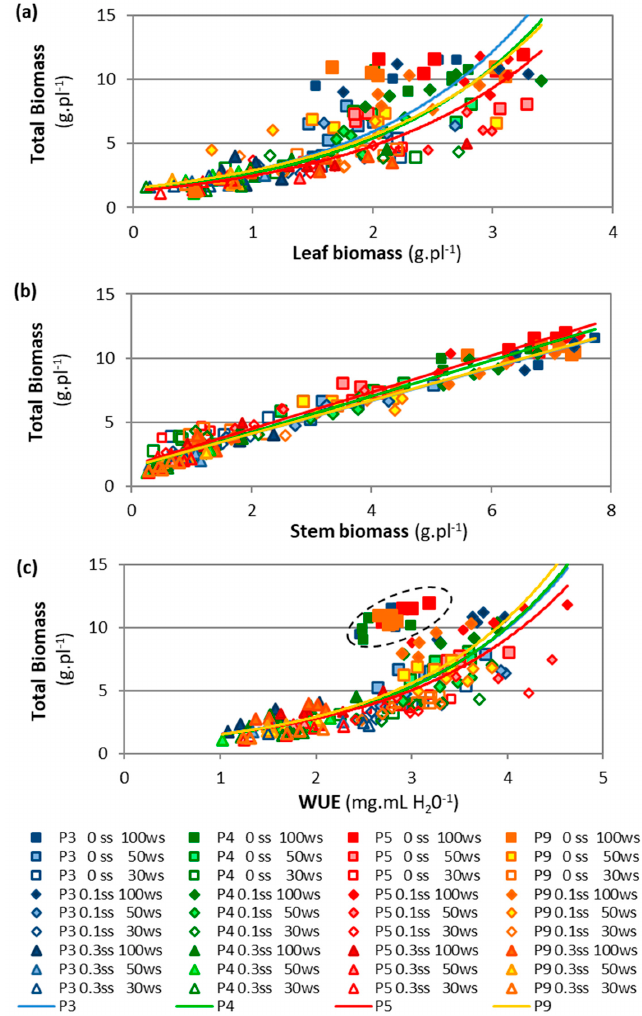
Figure 4. Relationship between total biomass and leaf biomass ( a ), stem biomass ( b ), or water-use efficiency (WUE) ( c ) of four accessions (P3, P4, P5, P9) grown under three drought levels (0 WS, 50 WS, or 70 WS, corresponding to 100%, 50%, or 30% water capacity, respectively) combined with three salinity levels (0 SS, 0.1 SS, or 0.3 SS, corresponding to 0.0, 0.1, or 0.3 M NaCl, respectively). Colored lines show the behavior of each accession. For leaf biomass, P3: y = 1.40e 0.72x R 2 = 0.75 ***, P4: y = 1.32e 0.71x R 2 = 0.79 ***, P5: y = 1.28e 0.66x R 2 = 0.80 ***, P9: y = 1.49e 0.66x R 2 = 0.60 ***; for stem biomass, P3: y = 1.29x + 1.50 R 2 = 0.97 ***, P4: y = 1.40x + 1.44 R 2 = 0.96 ***, P5: y = 1.43x + 1.63 R 2 = 0.96 ***, P9: y = 1.30x + 1.51 R 2 = 0.95 ***; and for WUE, P3: y = 0.83e 0.62x R 2 = 0.60 ***, P4: y = 0.78e 0.64x R 2 = 0.62 ***, P5: y = 0.84e 0.60x R 2 = 0.62 ***, P9: y = 0.79e 0.65x R 2 = 0.60